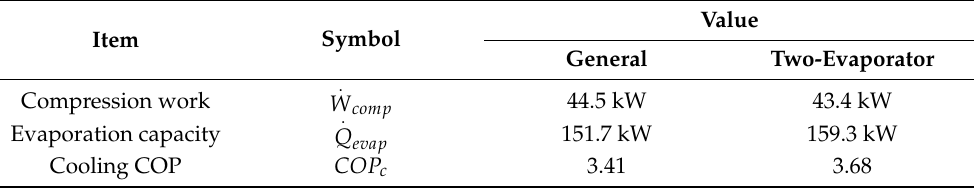
Table 2. Results of the cycle analysis of general and two-evaporator heat pump